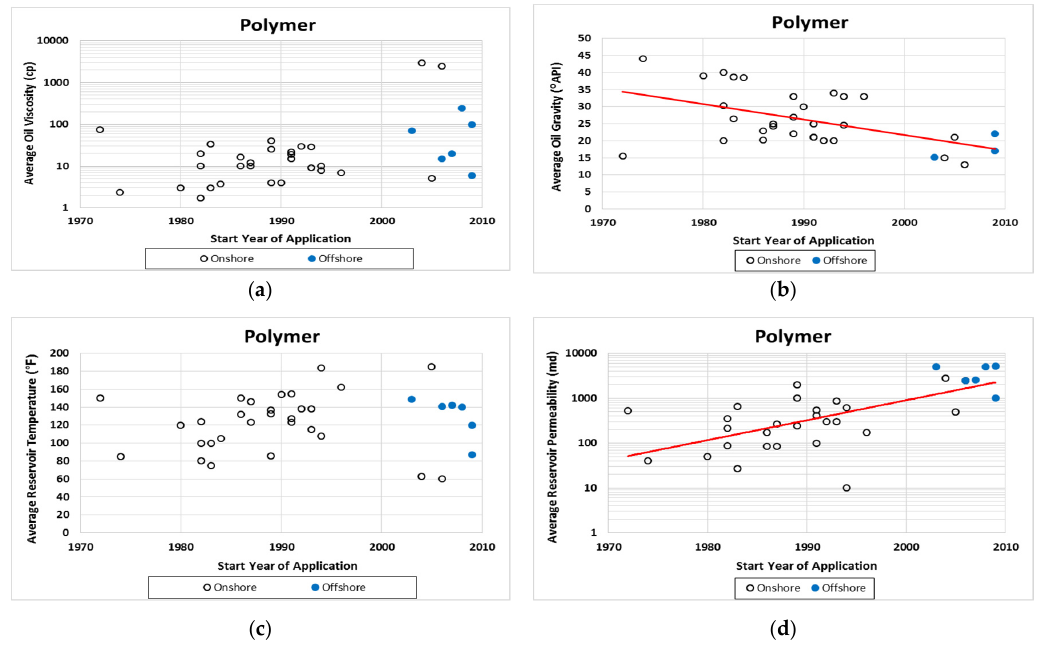
Figure 7. Application data for the polymer process by start year of application. ( a ) Oil viscosity; ( b ) Oil gravity; ( c ) Reservoir temperature; ( d ) Reservoir permeability.